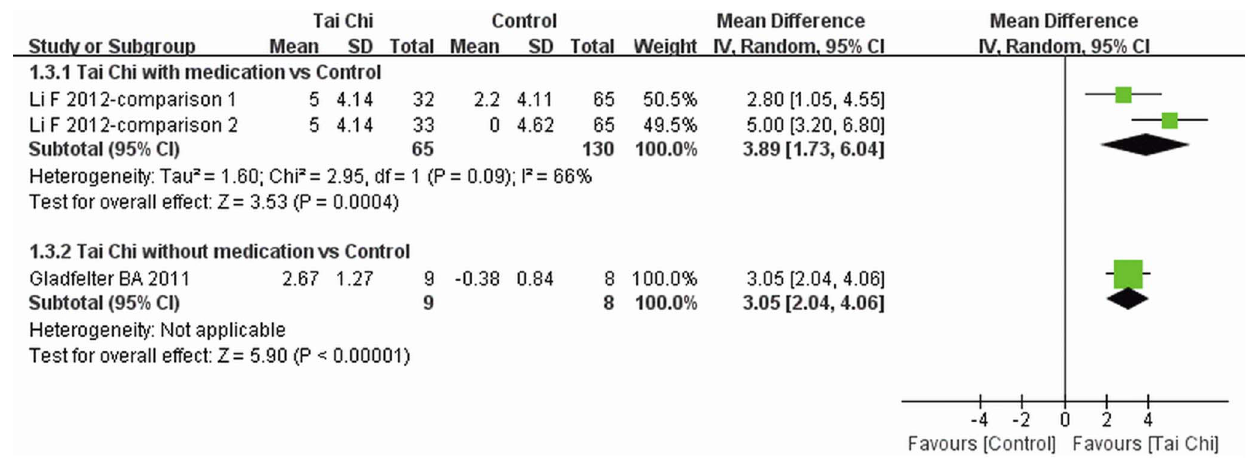
Figure 5. The effect of Tai Chi on FRT. Subgroup analysis was performed according to whether or not medications were included in the intervention. A random model was used to address the high heterogeneity. FRT, functional reach test.